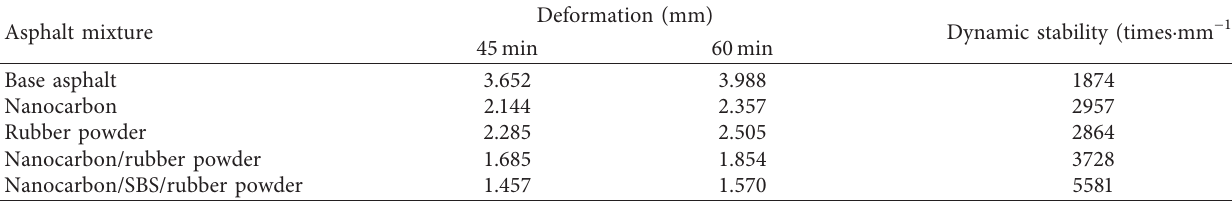
Table 8: Results of the rutting test.